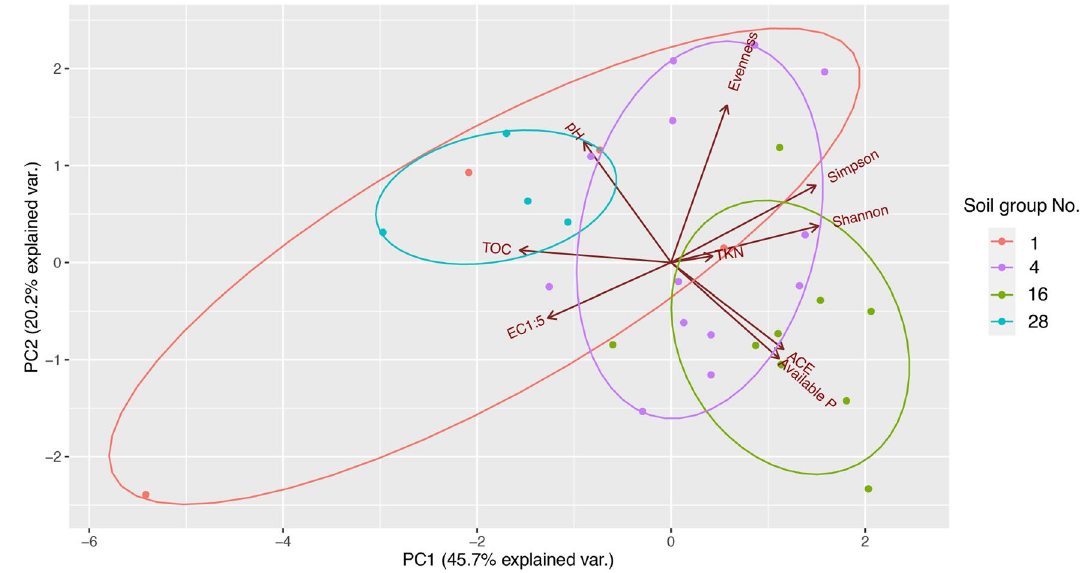
Figure 3. Principal component analysis (PCA) of soil nutrient characteristics and bacterial diversity indices of different soil groups in agricultural areas in Saraburi province. Each soil group No. is represented in red (No.1), purple (No.4), green (No.16), and blue (No.28). Soil